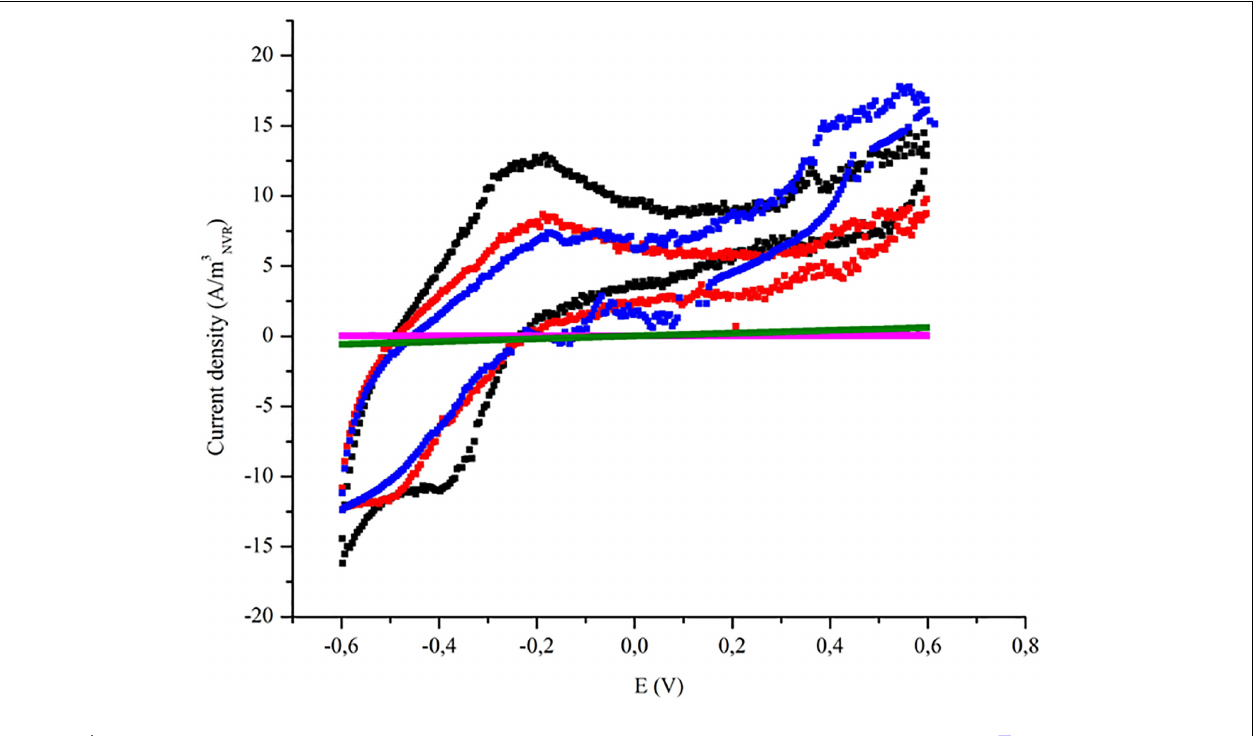
FIGURE 4 | Cyclic voltammograms during different stages where ME-FBR was operated under different anode potentials. Symbols: (cid:4) applied anode potential of + 600 mV, (cid:4) applied anode potential of + 400 mV, (cid:4) applied anode potential of + 200 mV, (cid:4) applied anode potential of − 200 mV, (cid:4) blank—abiotic conditions.